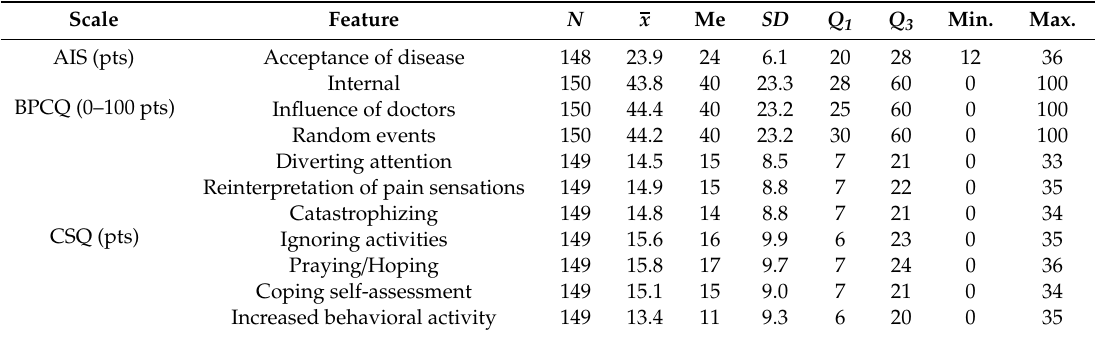
Table 6. Descriptive statistics for AIS, Beliefs about Pain Control Questionnaire (BPCQ), and Coping Strategies Questionnaire